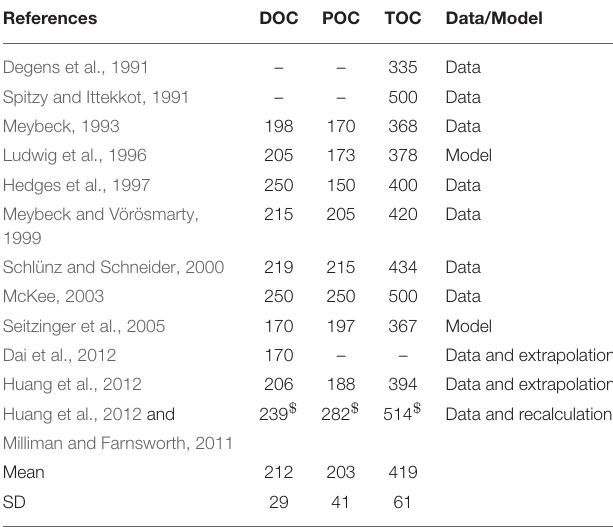
TABLE 1 | Estimations of the global riverine organic carbon input to the oceans after